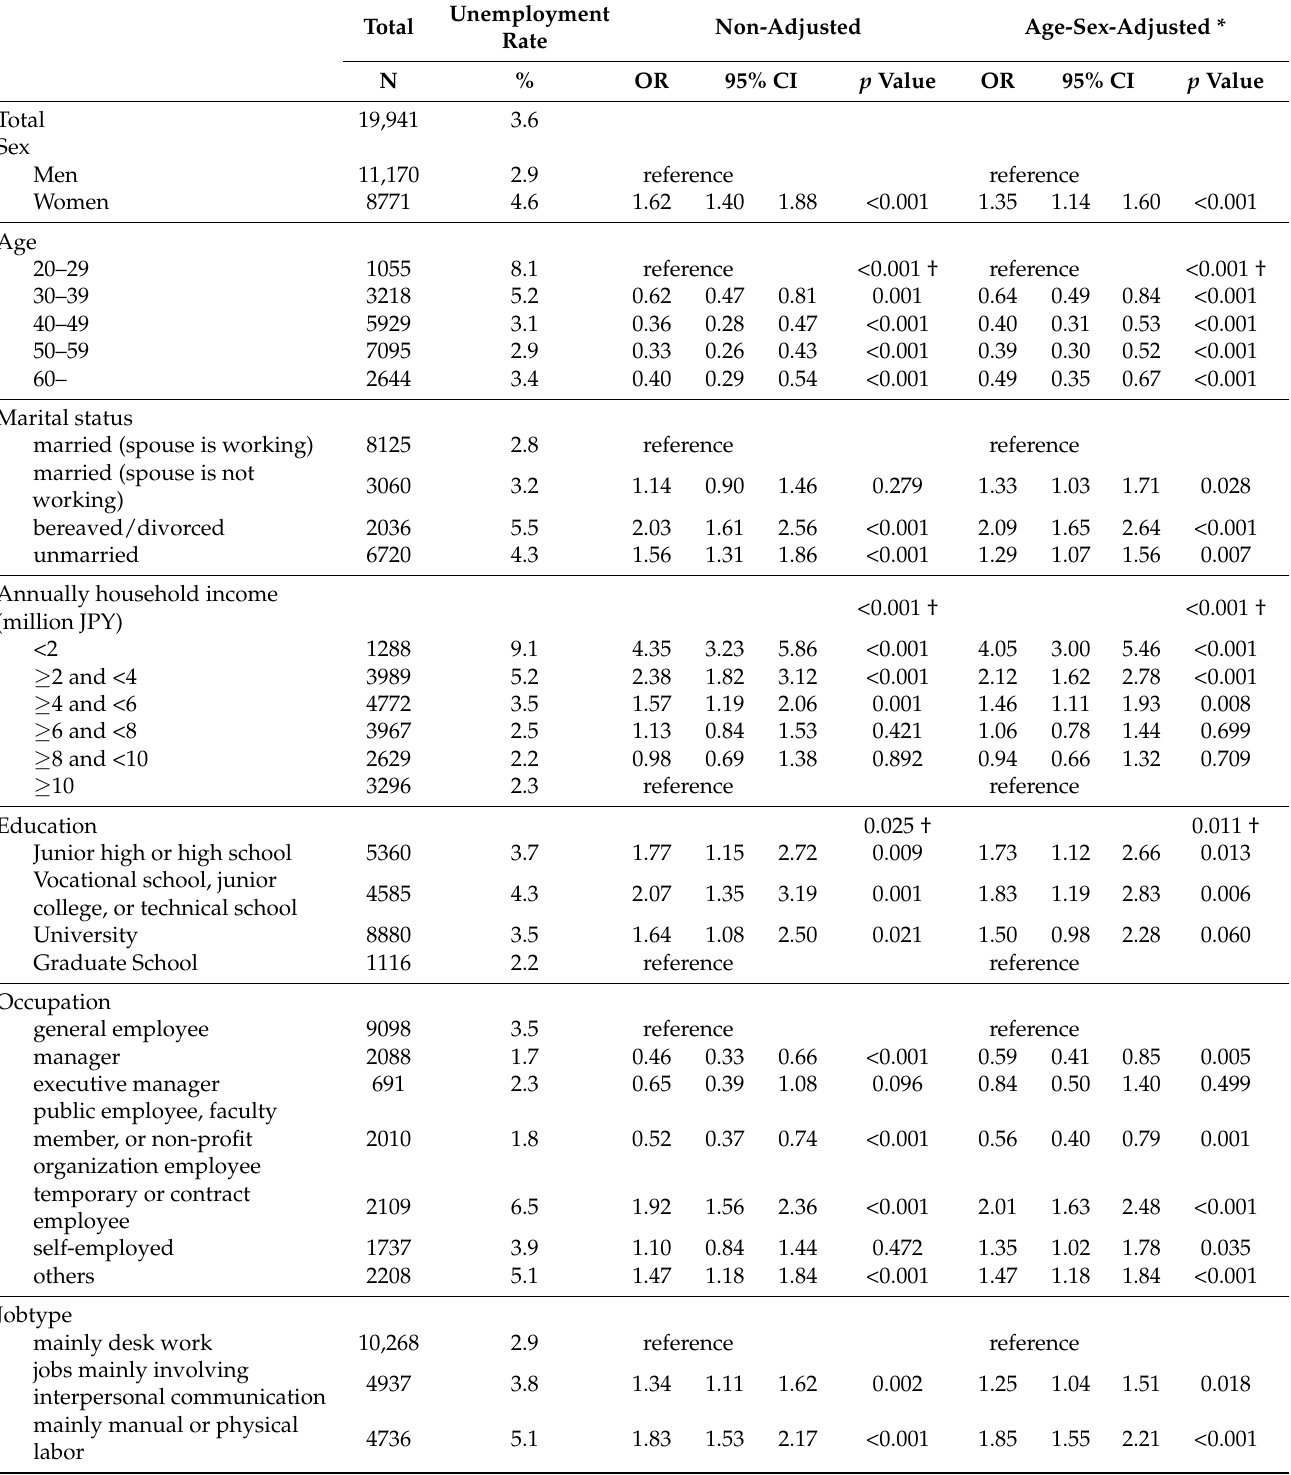
Table 2. The association between sociodemographic, work-related factors, and